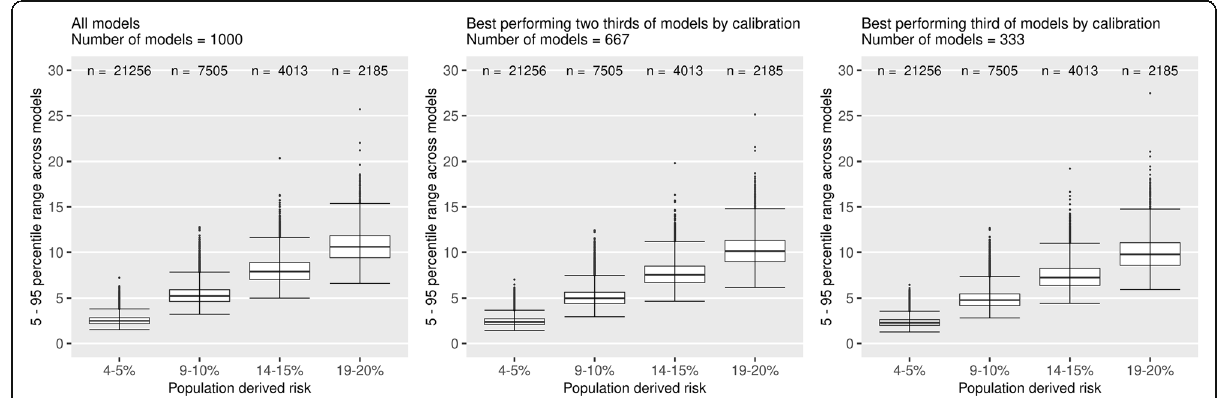
Fig. 4 Percentile ranges of risk for individuals, subsetted by calibration-in-the-large of the models (female cohort, N = 10,000). Each data point represents the 5 – 95th percentile range in risk for an individual across a group models defined by their calibration-in-the-large. Two thirds of models had calibration-in-the-large within 0.25% of the population-derived model, one third of models had calibration-in-the-large within 0.14% of the population-derived